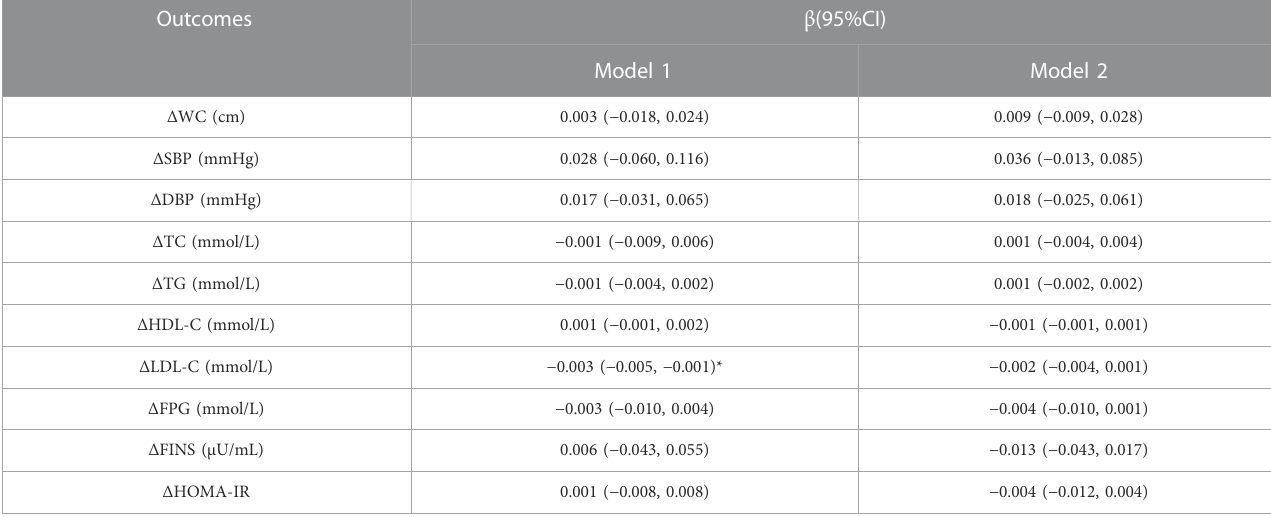
BMI,bodymassindex;DBP,diastolicbloodpressure;FPG,fastingplasmaglucose;FINS,fastinginsulin;HOMA-IR,homeostasismodelassessmentindexofinsulinresistance;HDL-C,high-density lipoproteincholesterol;LDL-C,low-densitylipoproteincholesterol;SBP,systolicbloodpressure;TC,totalcholesterol;TG,Triglycerides.Model1=noadjustment;Model2:adjustedforage,gender, baseline BMI, baseline value; *, p < 0.05 for